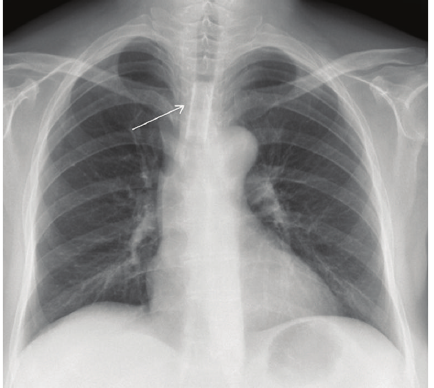
Figure 3: Chest X-ray with tracheal stent in